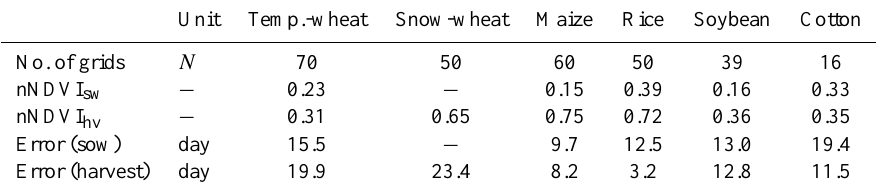
Table 4. Number of calibration grids, two calibrated crop calendar parameters (nNDVI sw and nNDVI hv ), and averaged errors (nNDVI) in sowing/harvesting dates between determined crop calendar and MIRCA2000 among calibration grids of the six crop types. Unit Temp.-wheat Snow-wheat Maize Rice Soybean Cotton No. of grids